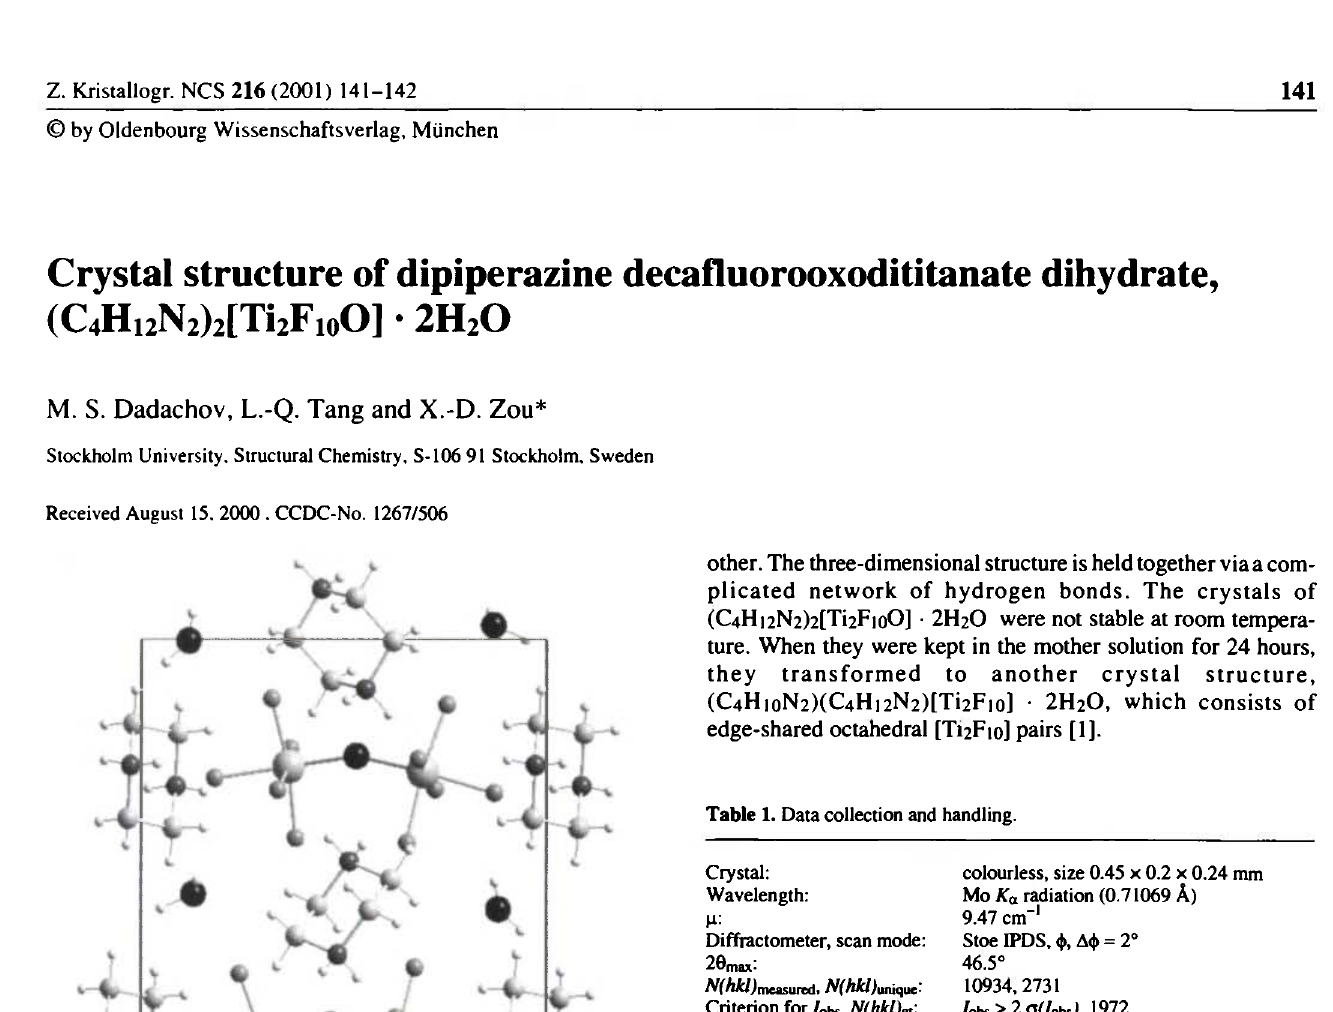
Table 2. Atomic coordinates and displacement parameters (in A 2